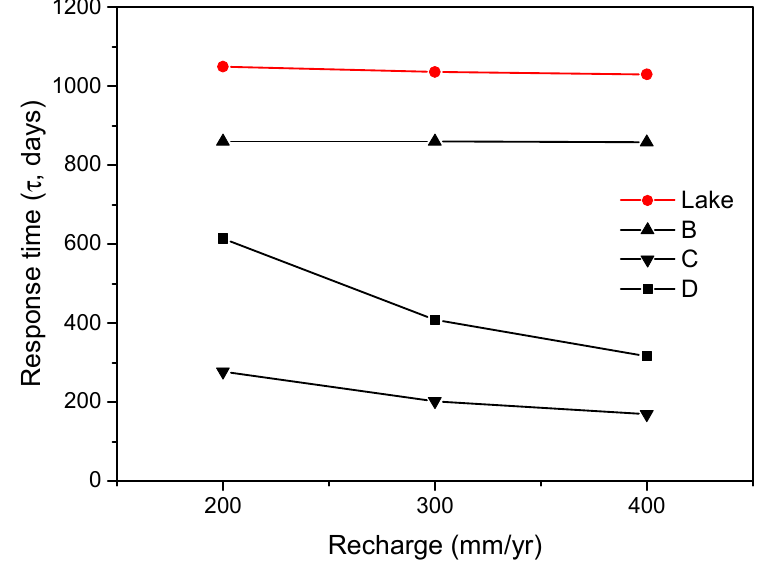
Figure 9. Relationship between recharge and the response time of lake stage, B, C and D to the climatic